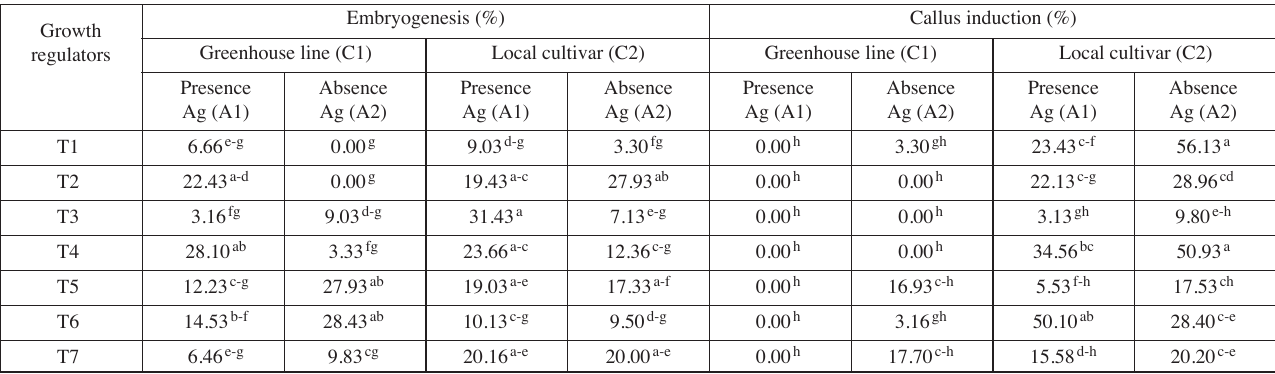
Tab. 8: Triple interaction effects of different hormonal combinations, genotypes and absence or presence of AgNo 3 on embryogenesis and callus induction in experiment